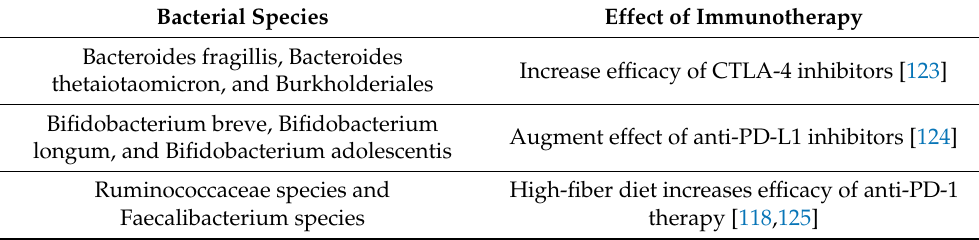
Table 5. Effect of microbiota species on checkpoint inhibitors. Bacterial Species Effect of Immunotherapy